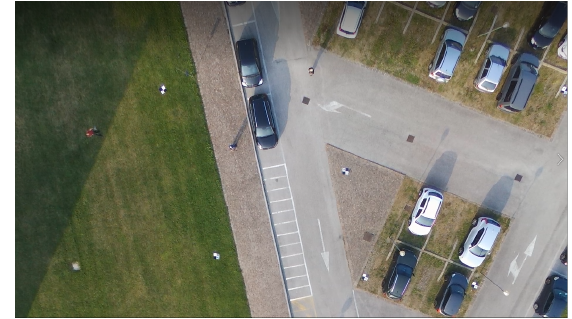
Figure 1. Drone view during the test.